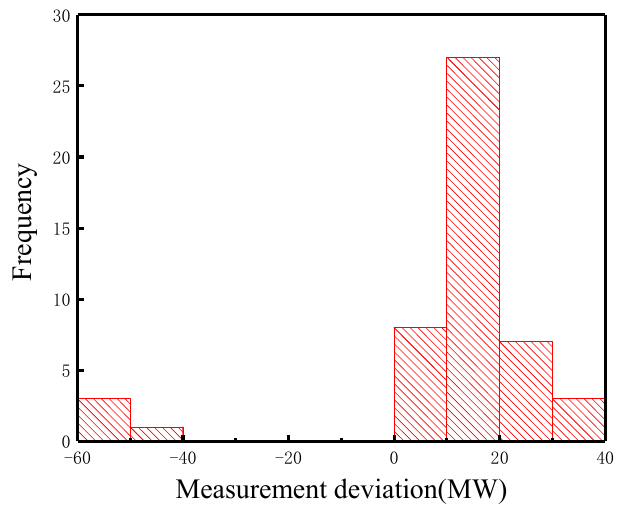
Figure 8. Histogram of spatial measurement deviation prior to filtering.